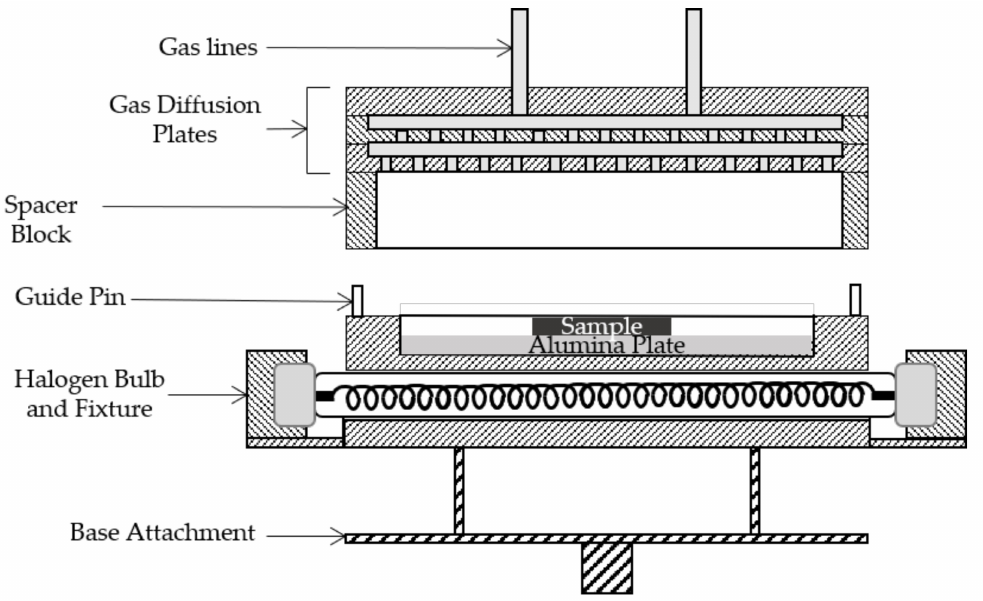
Figure 2. Schematic of the a high-temperature ALD (HTALD) Reactor. The top element is the movable gas di ff user assembly where the bottom element is the stationary heater